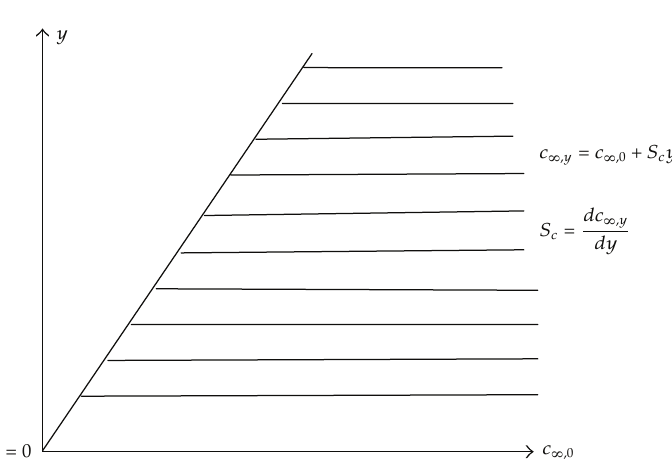
Figure 1: Model with concentration stratification.